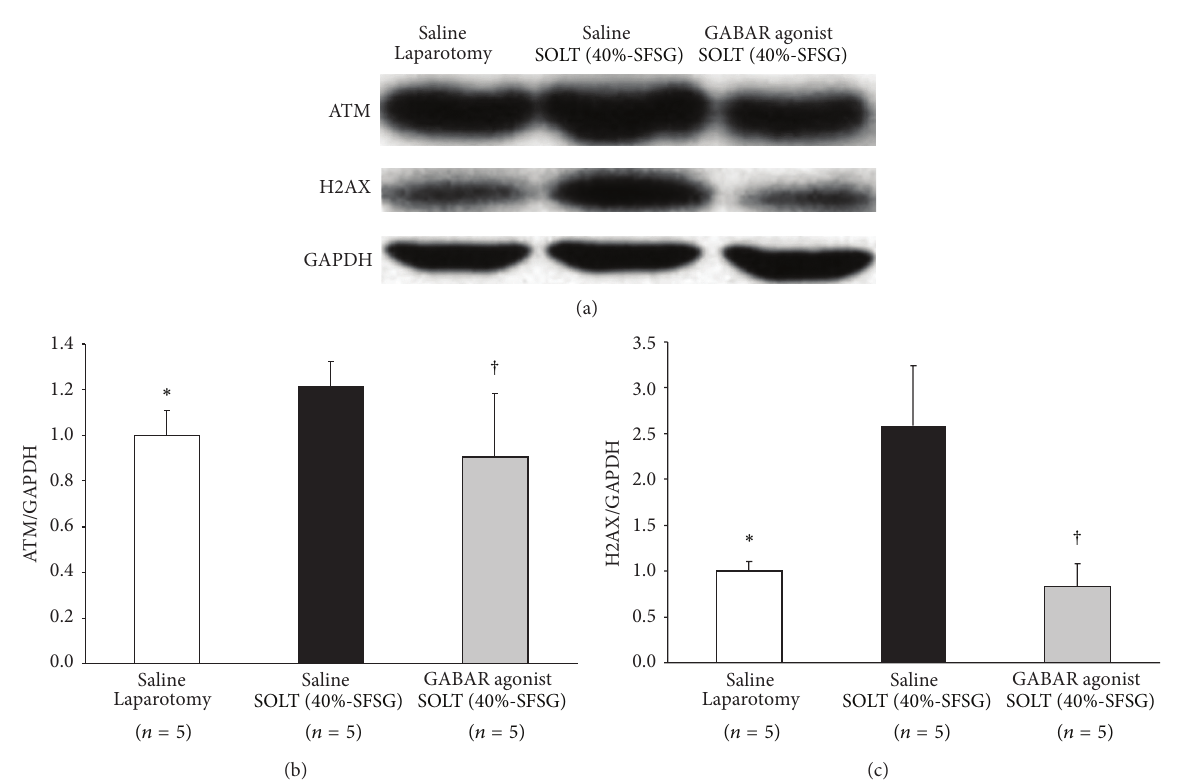
Figure6:WesternblotanalysesofATMandH2AX.(a)Intensities ofATM,H2AX,andGAPDH.(b)NormalizedATM.Thereweresignificant differences between laparotomy and SOLT with saline ( 𝑃 < 0.05 ∗ ) and between SOLT with saline and SOLT with GABAR agonist ( 𝑃 < 0.05 † ). (c) Normalized H2AX. There were significant differences between laparotomy and SOLT with saline ( 𝑃 < 0.05 ∗ ) and between SOLT with saline and SOLT with GABAR agonist ( 𝑃 < 0.05 † ). ATM, ataxia-telangiectasia mutated kinase; GABAR, 𝛾 -aminobutyric acid receptor; GAPDH, glyceraldehyde-3-phosphate dehydrogenase; SFSG, small-for-size graft; and SOLT, split orthotopic liver